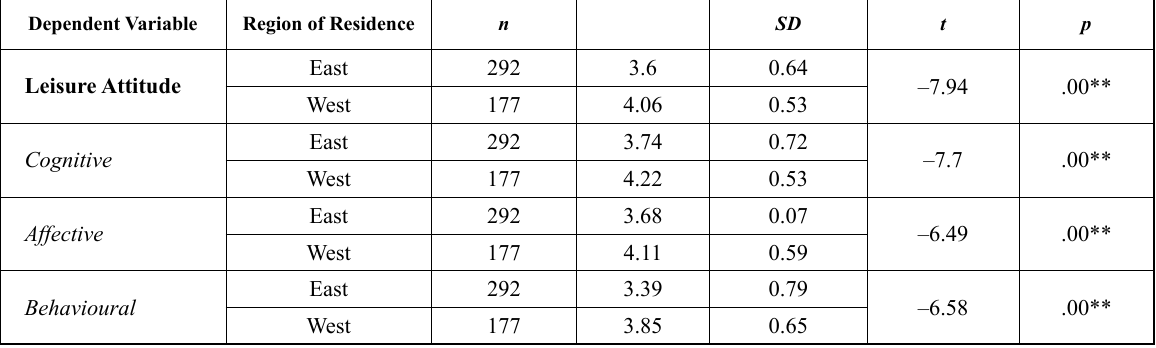
Table 5. Leisure attitude levels of the participants by the variable of the region of residence (East-West) Dependent